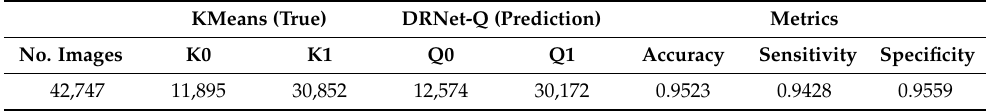
Table 11. CNN performance compared to KMeans.